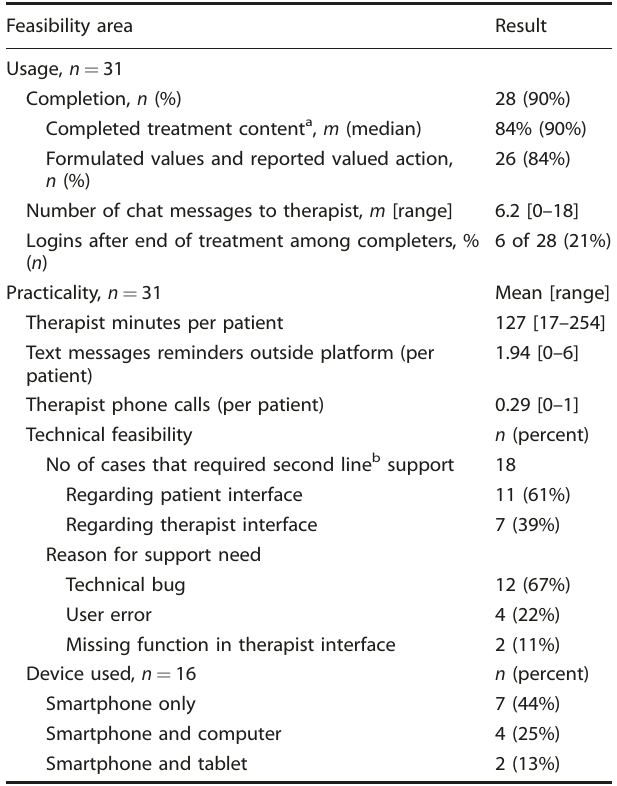
Table 3. Quantitative feasibility data from beta testing.